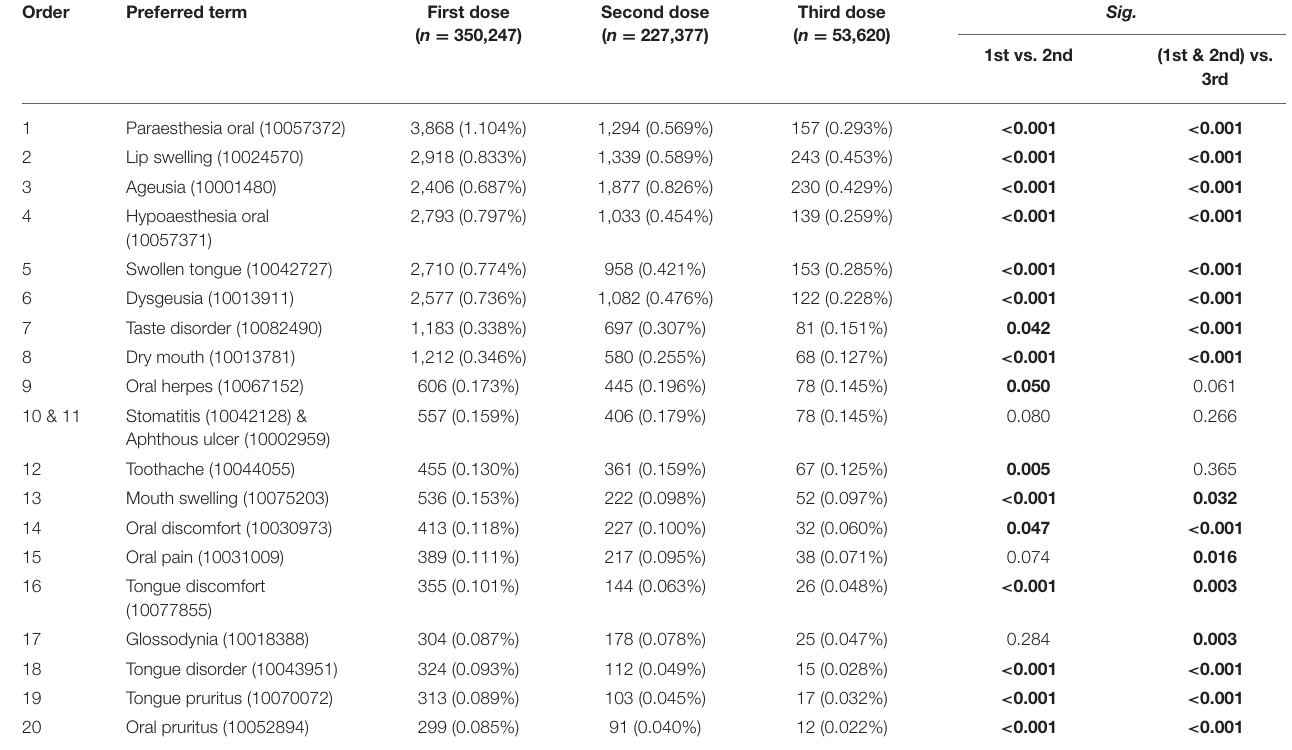
TABLE 4 | Top twenty oral adverse events reported after COVID-19 vaccines in the United States stratified by dose, January–December 2021 (CDC;